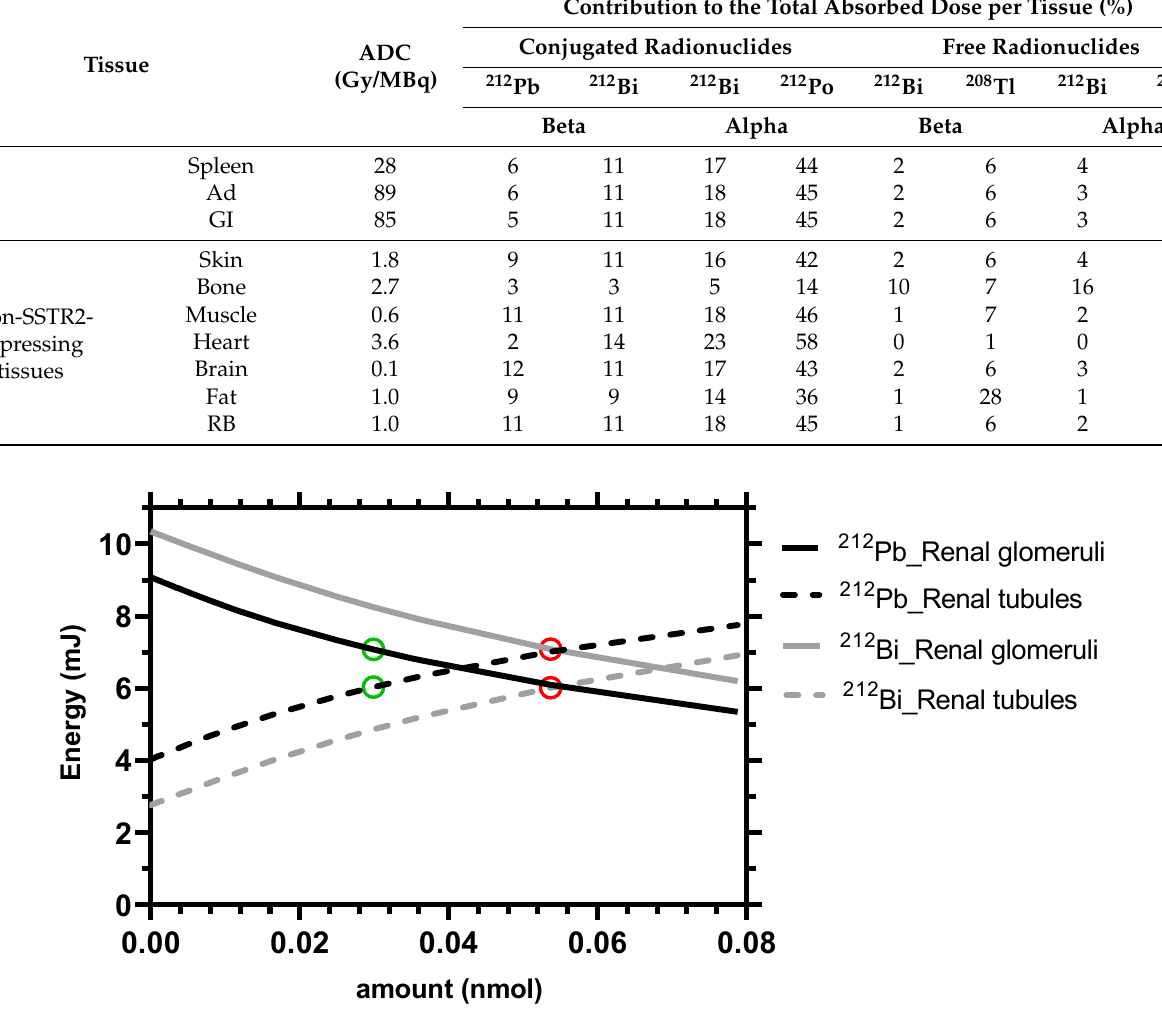
Figure 6. Energy absorbed in the renal glomeruli and proximal tubules resulting in 23 Gy in the kidneys depending on the administered amounts of [ 212 Pb]Pb-SSTA or [ 212 Bi]Bi-SSTA. The green and red circles indicate the energies released at the optimal amounts of [ 212 Pb]Pb-SSTA and [ 212 Bi]Bi-SSTA, respectively.